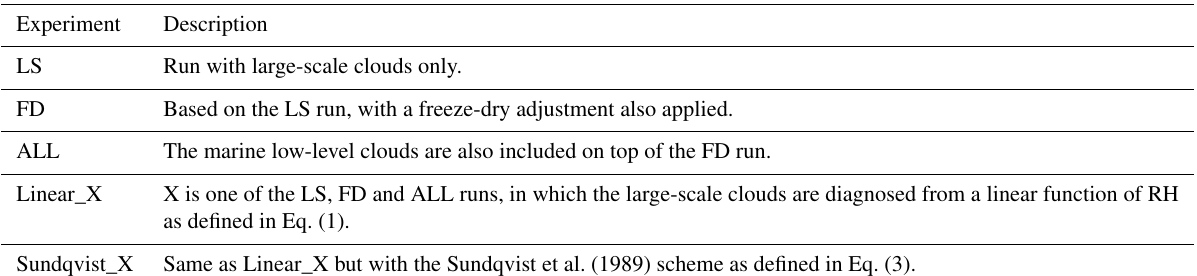
Table 2. Summary of the Isca fixed sea surface temperature (SST) simulations used in this study.